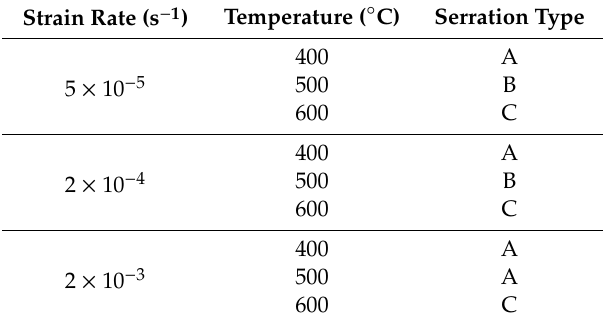
Figure 14. Stress vs. strain graph for the Al 0.5 CoCrCuFeNi HEA samples tested at strain rates of ( a ) 2 × 10 −3 s −1 , ( b ) 2 × 10 −4 s −1 , and ( c ) 5 × 10 −5 s −1 and temperatures of 400–600 °C (reproduced from Reference [180] with permission). Table 2. Strain rates, test temperatures, and serration types for the Al 0.5 CoCrCuFeNi HEA that underwent compression testing (from Reference